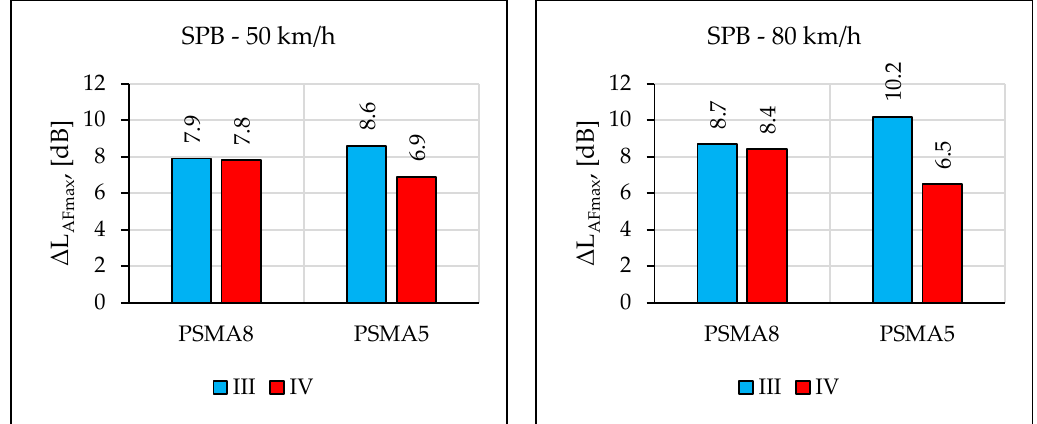
Figure 30. Differences between the maximum sound levels according to the SPB method obtained for the SMA11 pavement and the given poroelastic pavement.